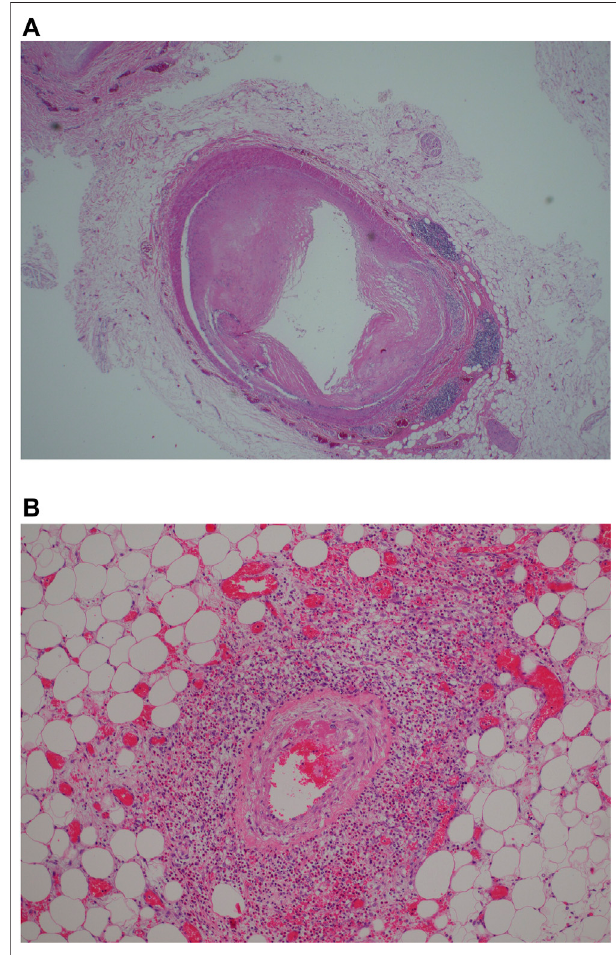
FIGURE 2 | (A) Remodeling of myocardial vesels showing myointimal hypertrophy/thickening with perivascular lymphoid aggregates (H&E, x200). (B) Perivascular in fl ammation involving epicardial vessel (H&E,